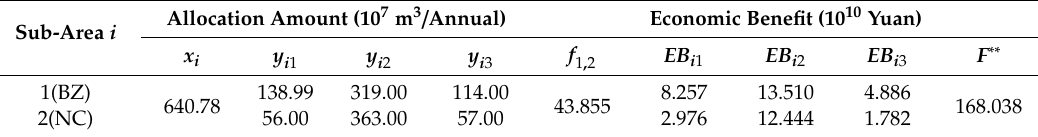
Table 6. Water allocation result under cooperation (information asymmetry, BZ and NC).